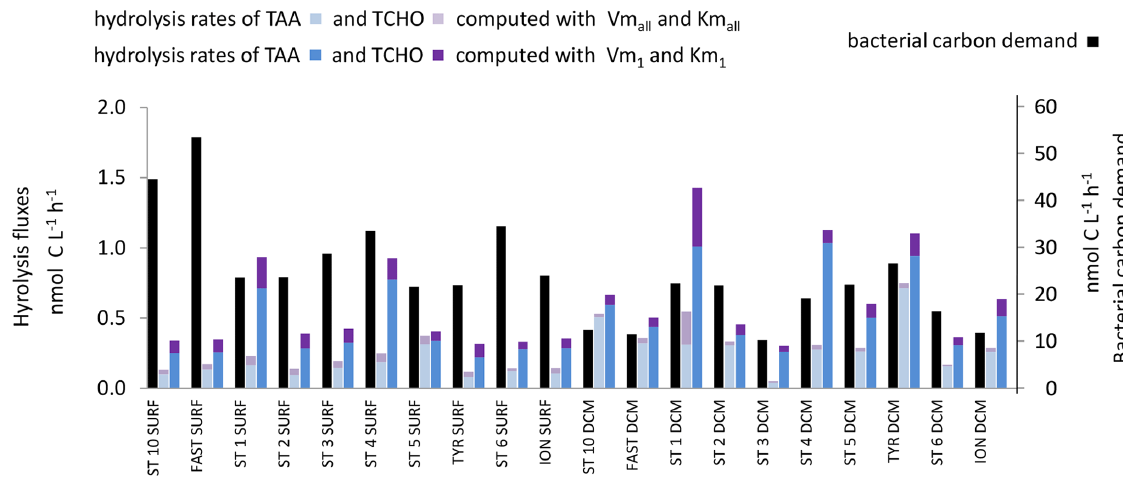
Figure 11. In situ hydrolysis rates of carbohydrates and proteins (nmolCL − 1 h − 1 ), determined from TAAs, TCHOs, and LAP and β GLU ectoenzymatic kinetics for the low- and high-affinity systems, and heterotrophic bacterial carbon demand (BCD), determined from BP assuming a bacterial growth efficiency of 10% in epipelagic waters. Note the different scale for bacterial carbon demand on the right.